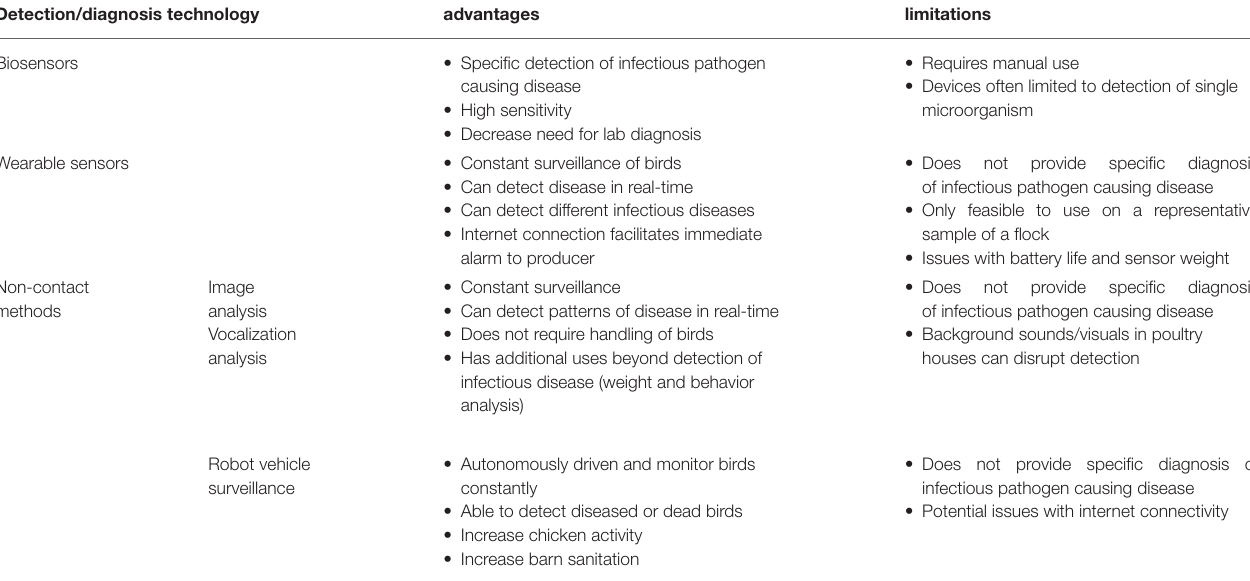
TABLE 1 | Summary of potential technologies that facilitate rapid detection or diagnosis of disease in